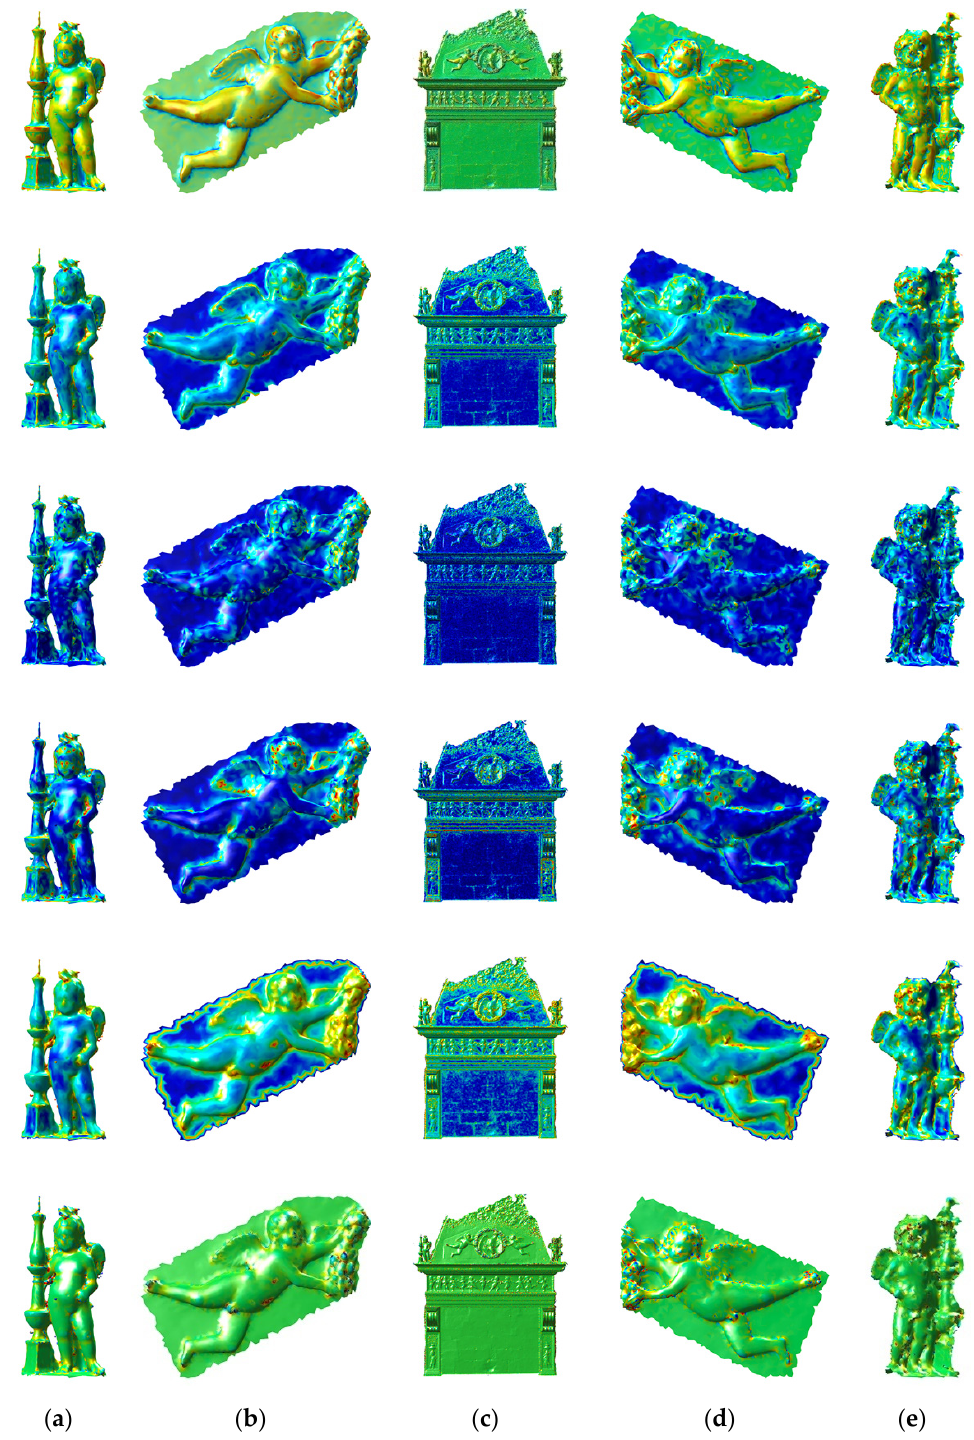
Figure A2. The input models (( a ) angelo-1L.obj, ( b ) angelo-2L.obj, ( c ) camino degli angeli.obj, ( d ) angelo-2R.obj, ( e ) angelo-1R.obj) rendered and texturized by the color map in accordance with all computed criteria from Table 1 and Section 4.2. Blue corresponds to low values and red to high values of the computed criteria.